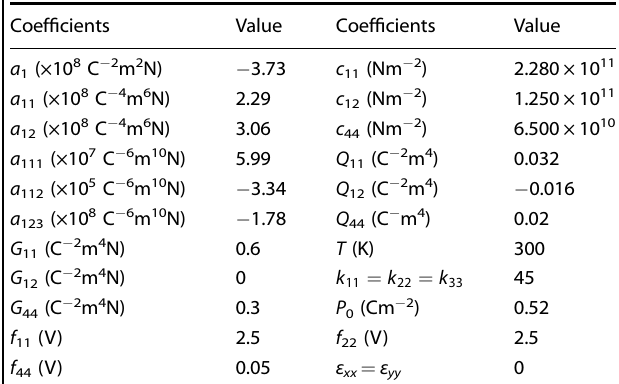
Table 1. The material coef fi cients of BiFeO 3 are used in phase- fi eld